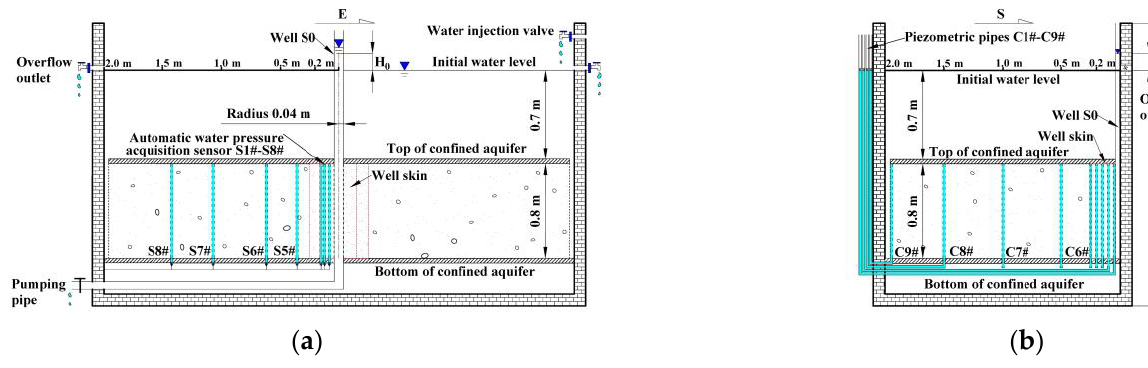
Figure 4. Section of indoor test platform. ( a ) East – West Section. ( b ) South – North Section.